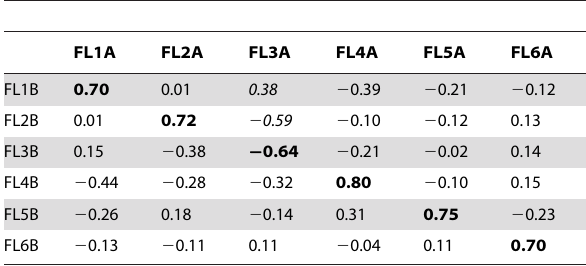
Table 6. Correlation among the FLs of the two chips (U133A and